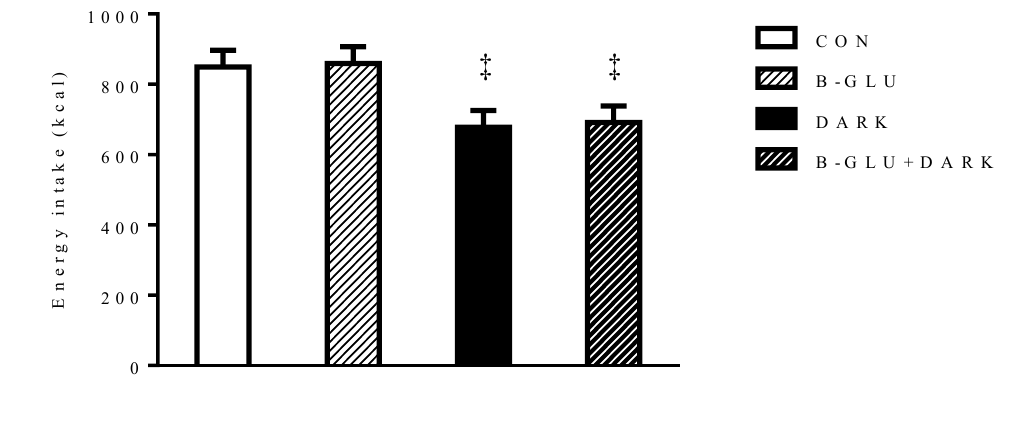
Figure 2. Mean energy intakes during ad libitum lunch.